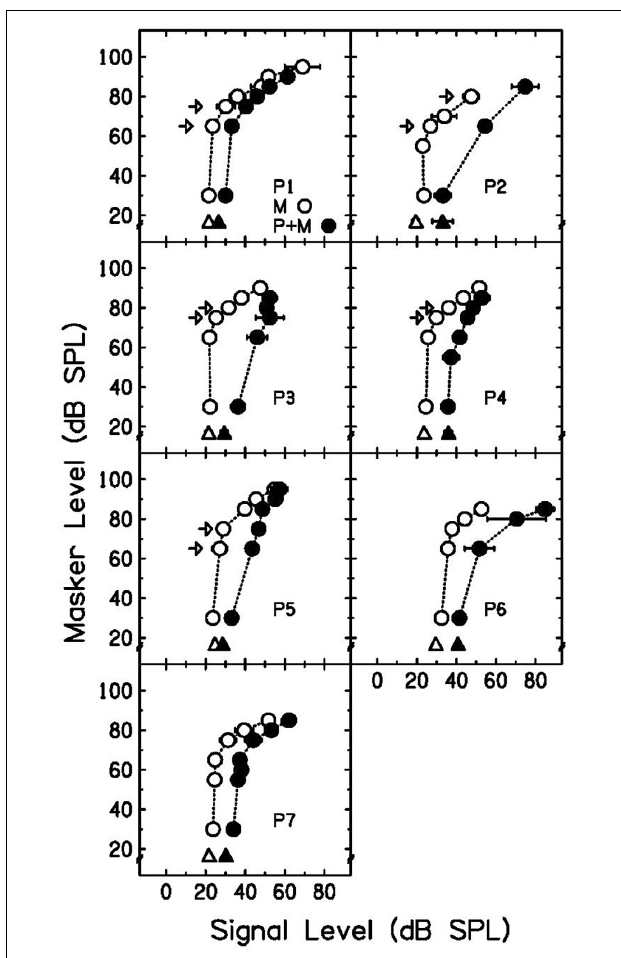
FIGURE 3 | Individual GOM functions and masker-absent gain reduction estimates. Signal thresholds for the masker-alone condition are plotted as open circles and signal thresholds with the addition of a precursor are plotted as filled circles. Signal threshold without a preceding masker is plotted as an open triangle, and signal threshold with a precursor and 20-ms delay is plotted as a filled triangle. The difference between the triangles is the masker-absent gain reduction estimate. Arrows indicate the off-frequency masker levels used in the equally-effective-masker conditions. Error bars represent one standard